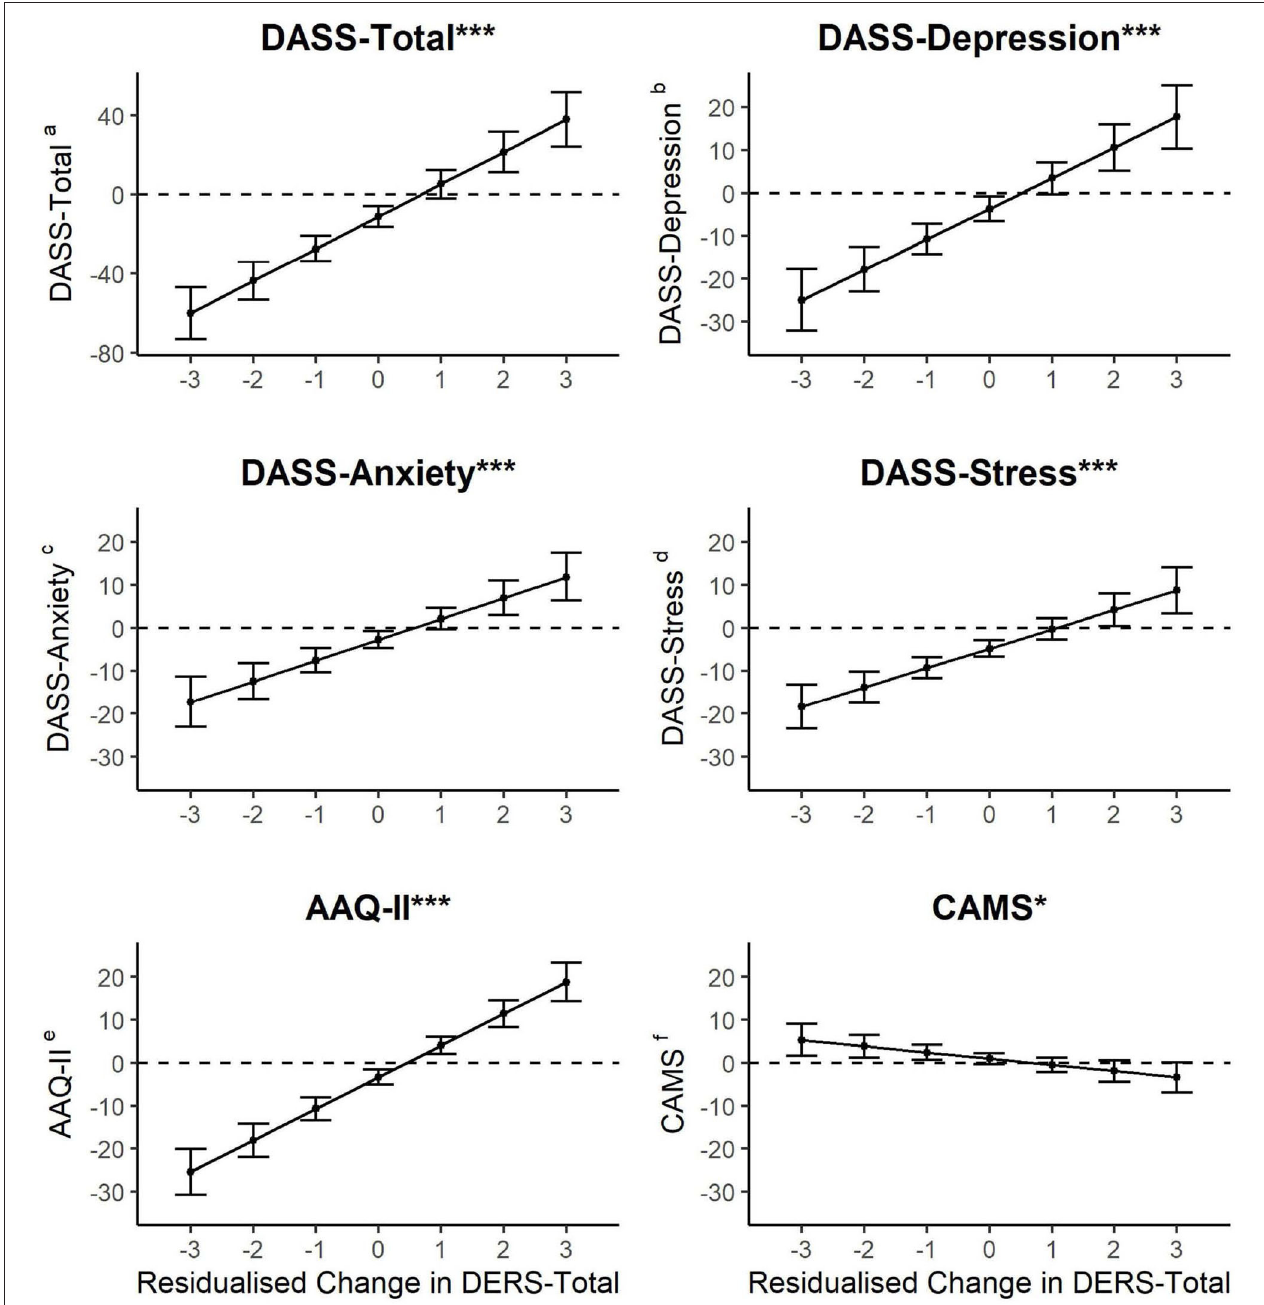
FIGURE 1 | Relationship between residualised change in DERS-Total and magnitude of change in a DASS-Total, b DASS-Depression, c DASS-Anxiety, and d DASS-Stress, e AAQ-II, and CAMS f from baseline to follow-up. Note * moderation effect p < 0.05; *** moderation effect p < 0.001. Figures present effects and 95% confidence intervals. Confidence intervals that do not overlap zero represent statistically significant change from baseline to follow